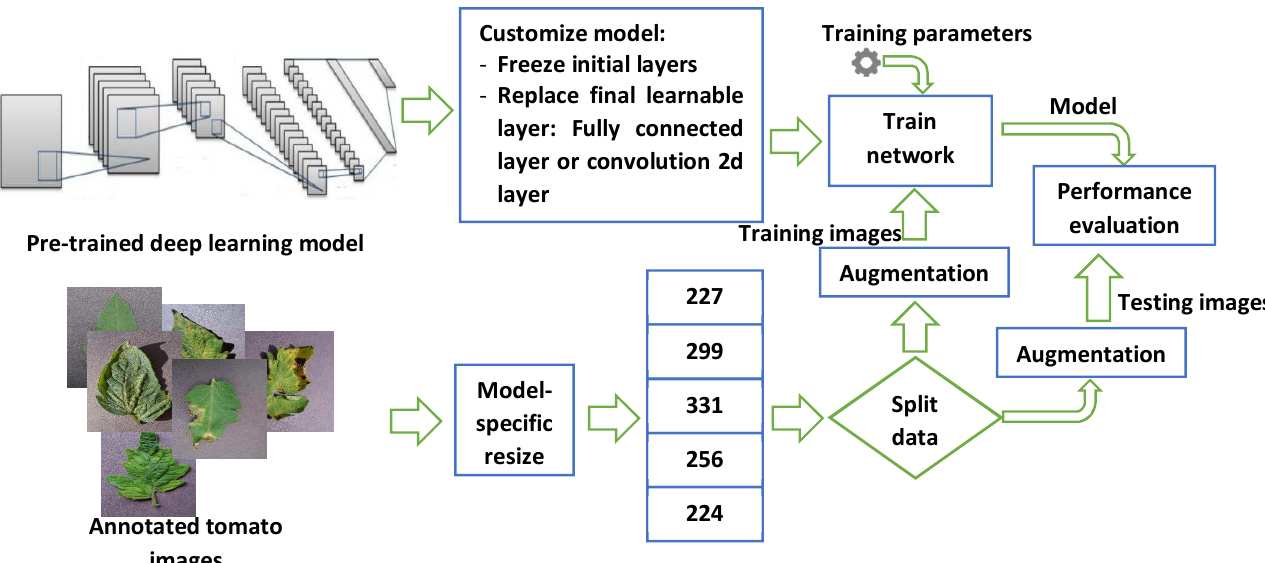
Figure 1. A diagram of all phases of the proposed approach.